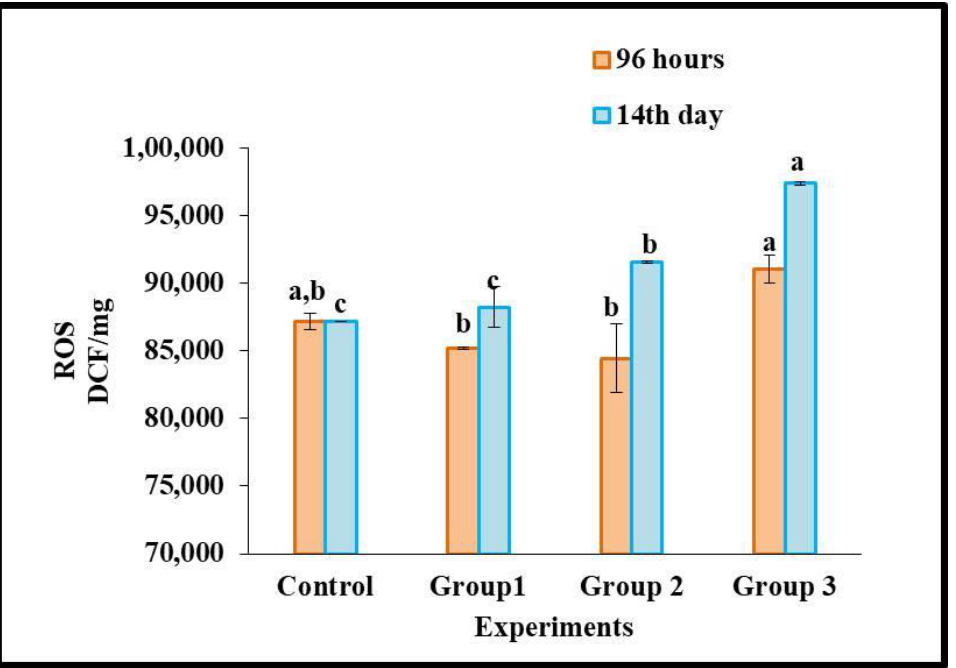
Figure 2. Generation of Reactive oxygen species (ROS) after 96 h and 14 days of dietary exposure to polypropylene microplastics [various concentrations of 100 mg/ kg (Group 1), 500 mg/kg (Group 2), 1000 mg/kg (Group 3)] in the liver tissues of Oreochromis mossambicus (Duncan’s multiple range tests significant value ( p < 0.05). Statistically significant differences ( p < 0.05) between experimental groups correspond to different alphabet letters.